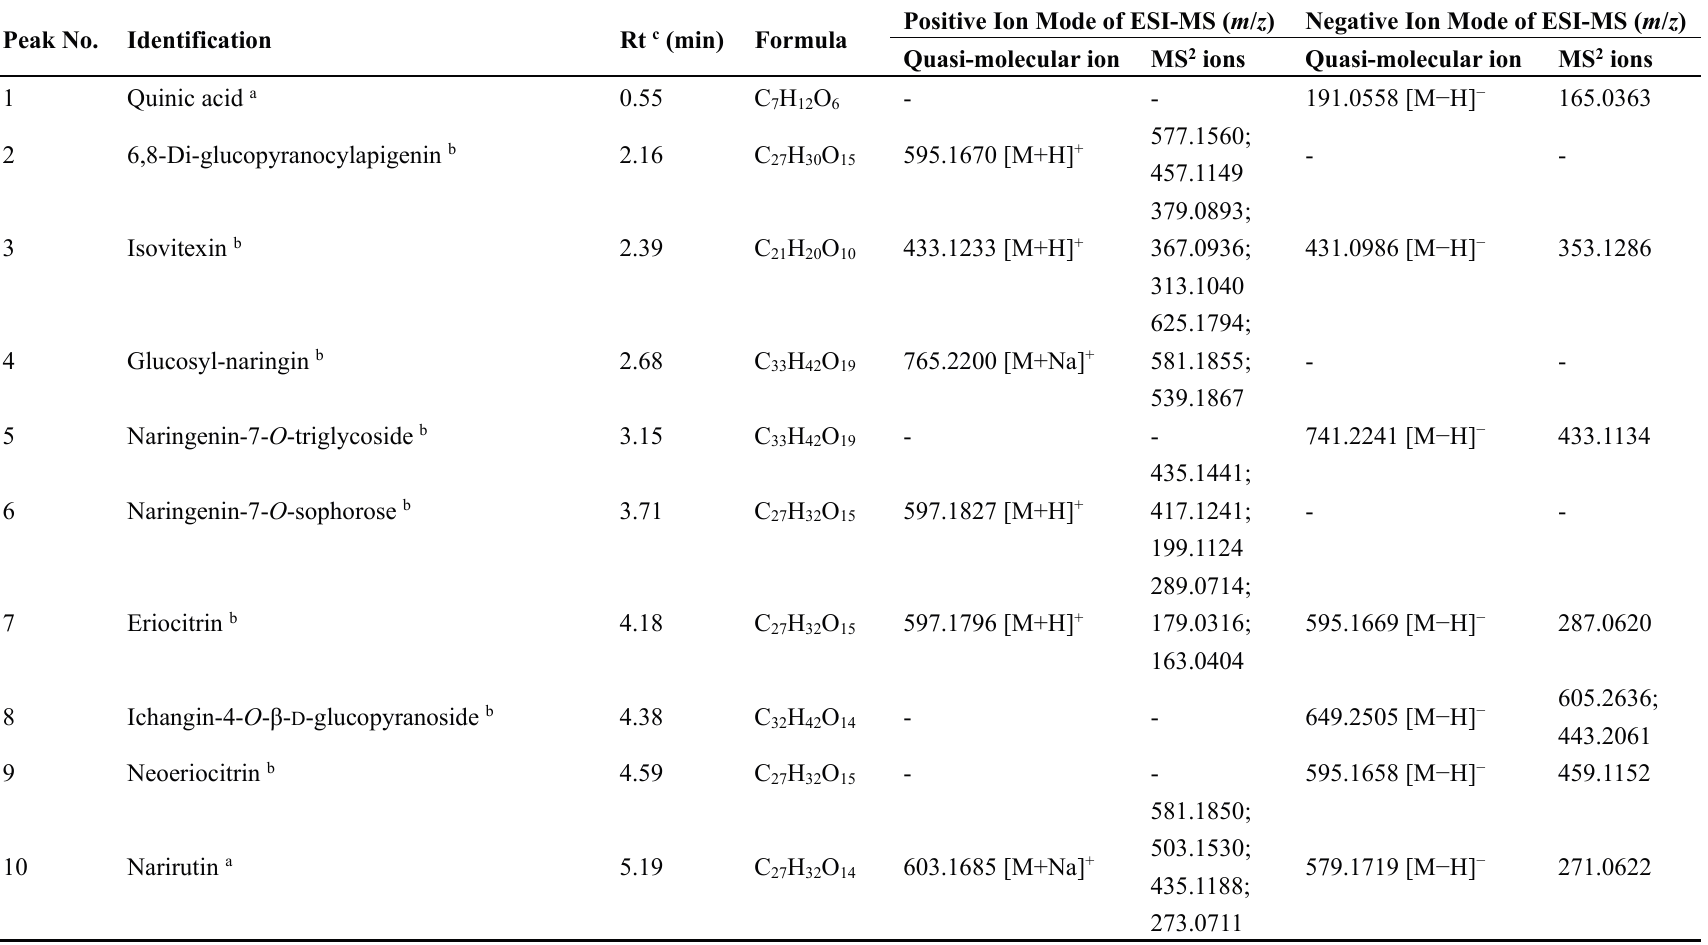
Table 1. Identification of the chemical constituents in ZQ aqueous extract by UPLC-Q-TOF/MS analysis. Peak